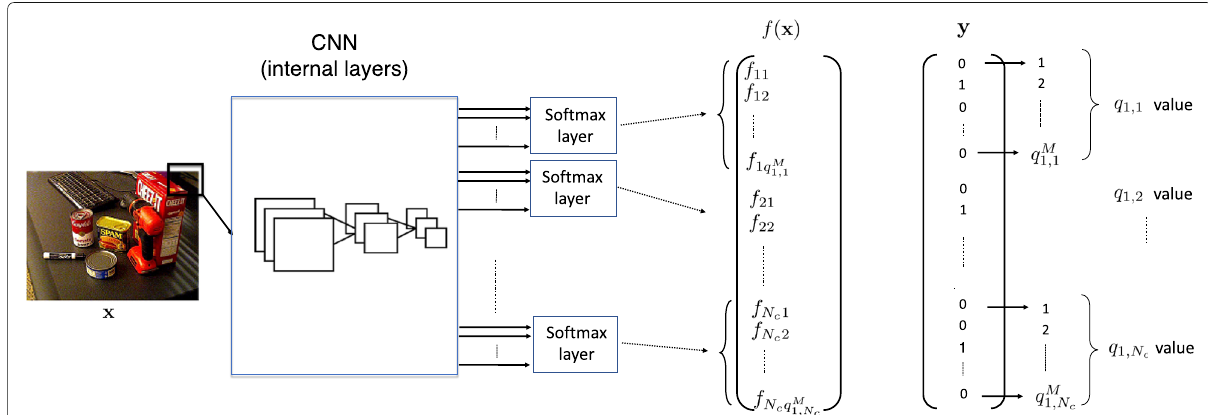
Fig. 1 Scheme of the CNN classification-like structure considered in this